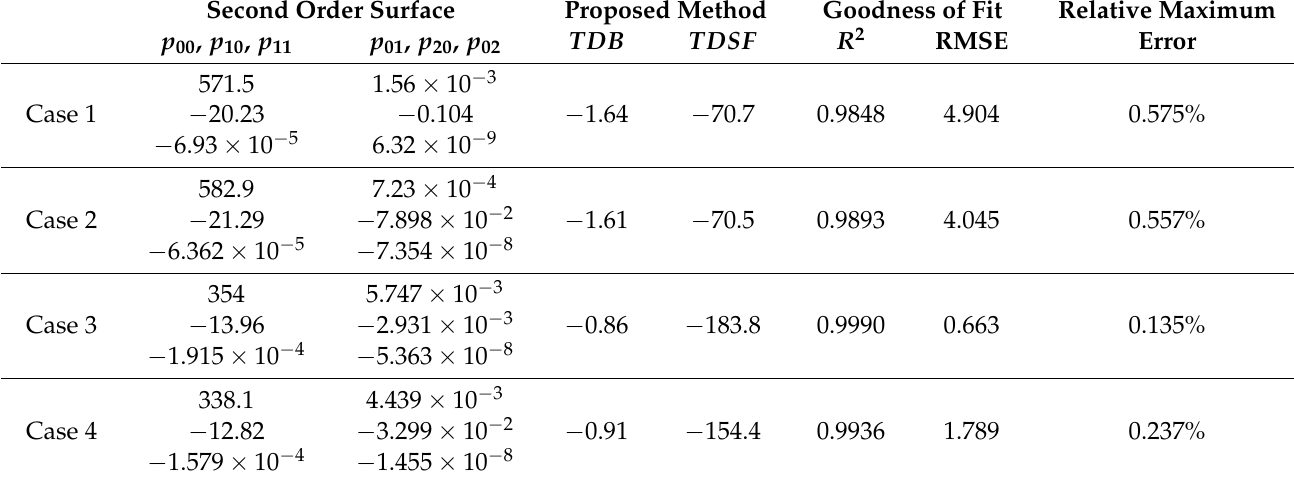
Table A1. Fit using the proposed formula of second-order calibration